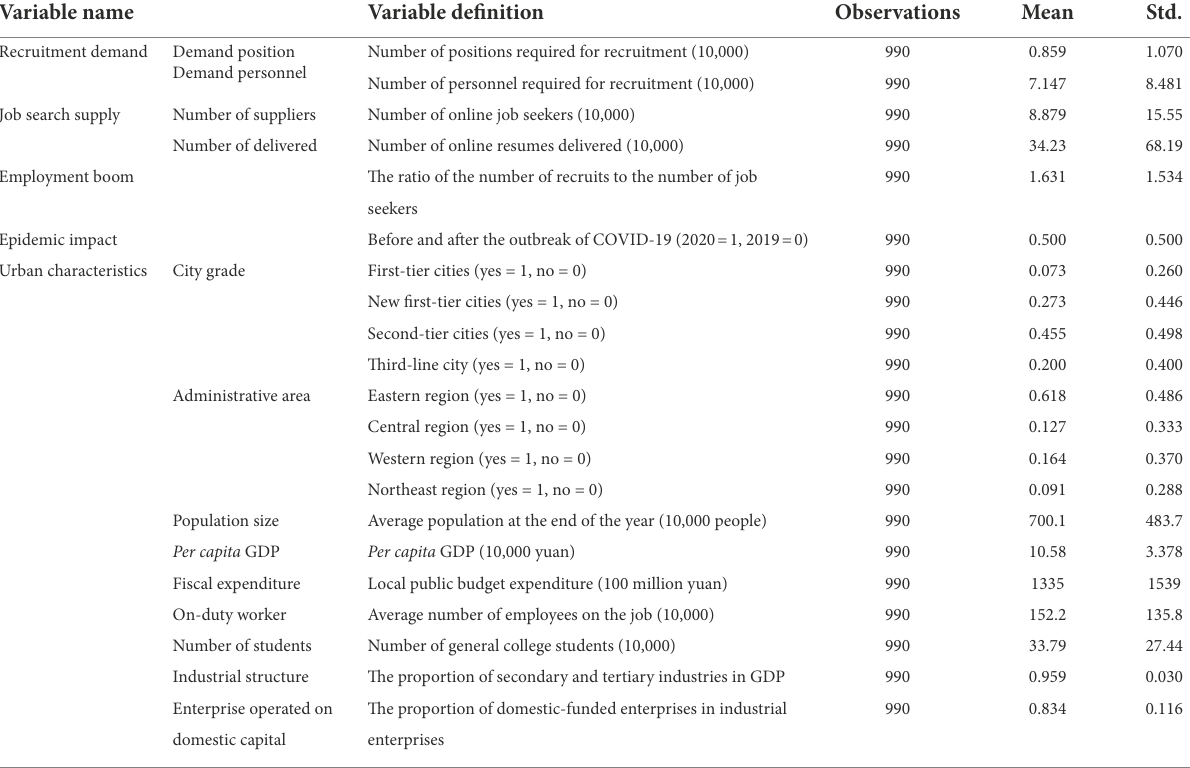
TABLE 1 Variables description and description